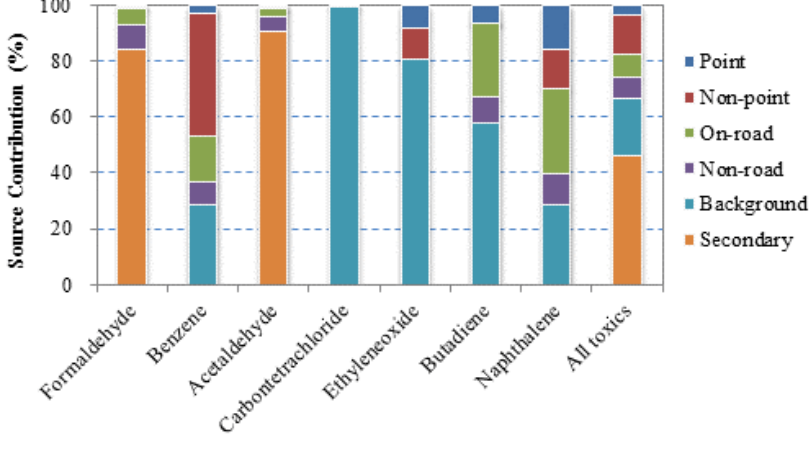
Figure 2. Contributions of various sources to cancer risks in Cancer